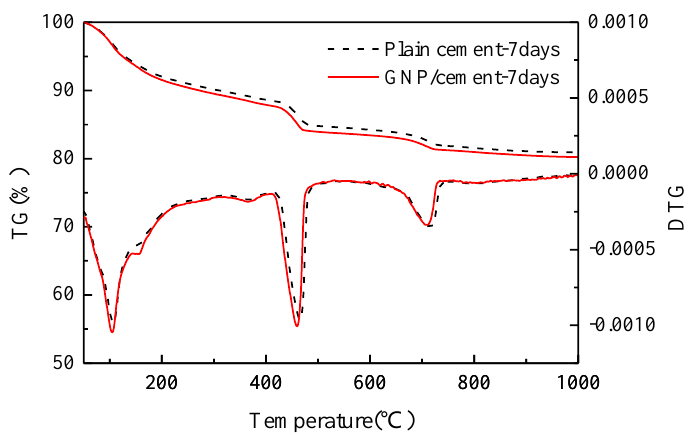
Figure 7. Thermal analysis (TG/DTG) curves of plain cement and GNP-cement composite at the age of 7 days.